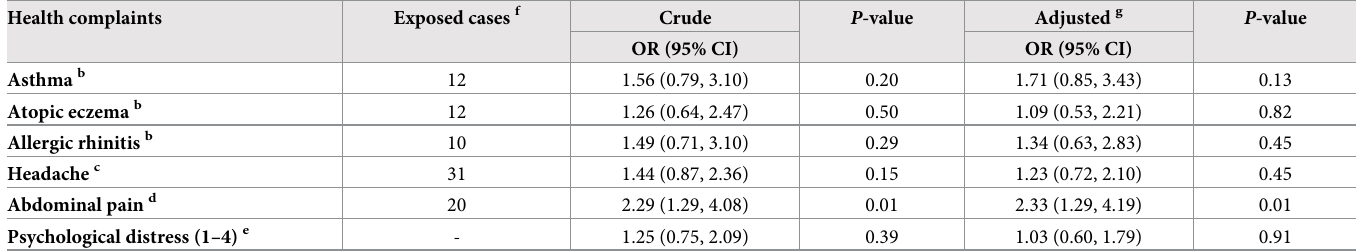
Table 2. Logistic regression analyses of the association between health complaints at baseline and persistent musculoskeletal pain a at 2-year follow-up.